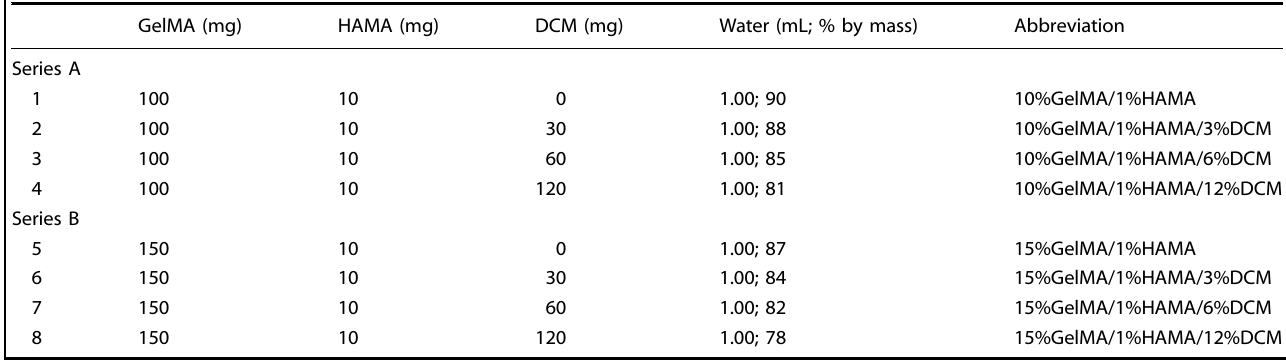
Table 2. Compositions of the hybrid hydrogel. GelMA